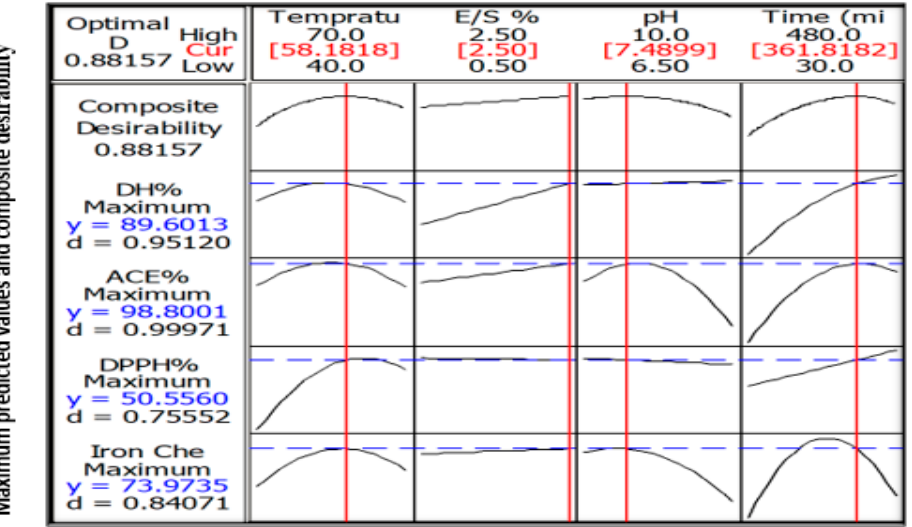
Figure 6. The predicted maximum responses (DH, ACE-inhibitory, DPPH • radical scavenging, ferrous ion chelating activity) based on predicted optimum hydrolysis parameters (temperature, E / S ratio, pH and hydrolysis time). Composite desirability = overall desirability encompassing all responses and d = individual desirability. Optimum hydrolysis parameters are denoted as red lines while the maximum responses are denoted as blue dotted lines.